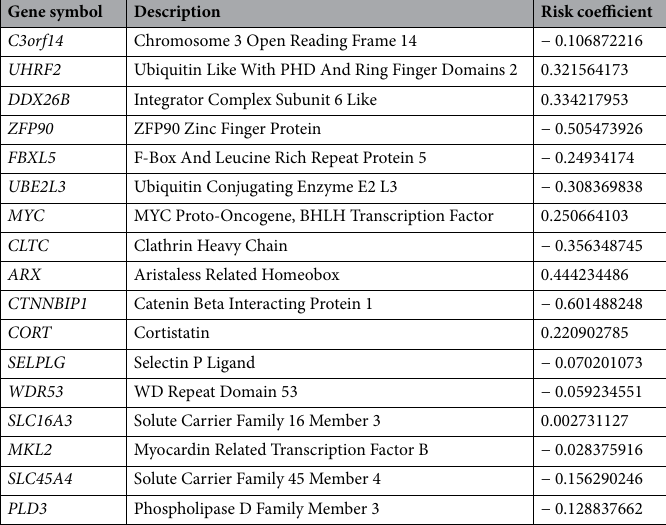
Table 2. Prognostic genes obtained from LASSO Cox regression